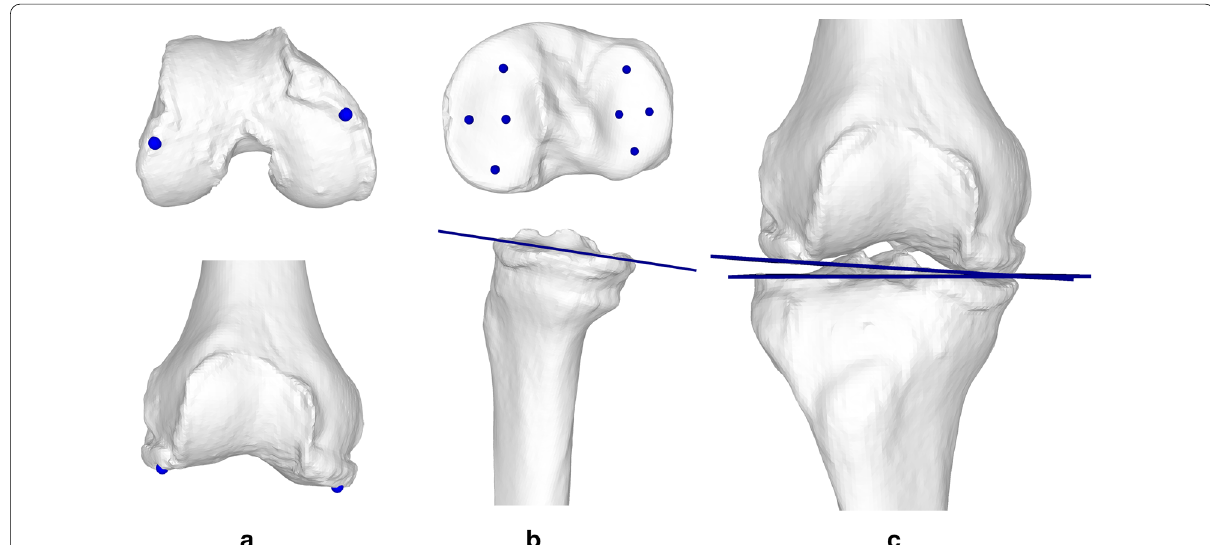
Fig. 5 Calculation of the joint line convergence angle in 3D. a The FCT is defined by the two most distal points, one on each condyle. b The TCT is found by defining the tibial plateau plane using user selected points on the plateau. C Both the FCT and the tibial plateau plane are projected to the frontal plane to find the